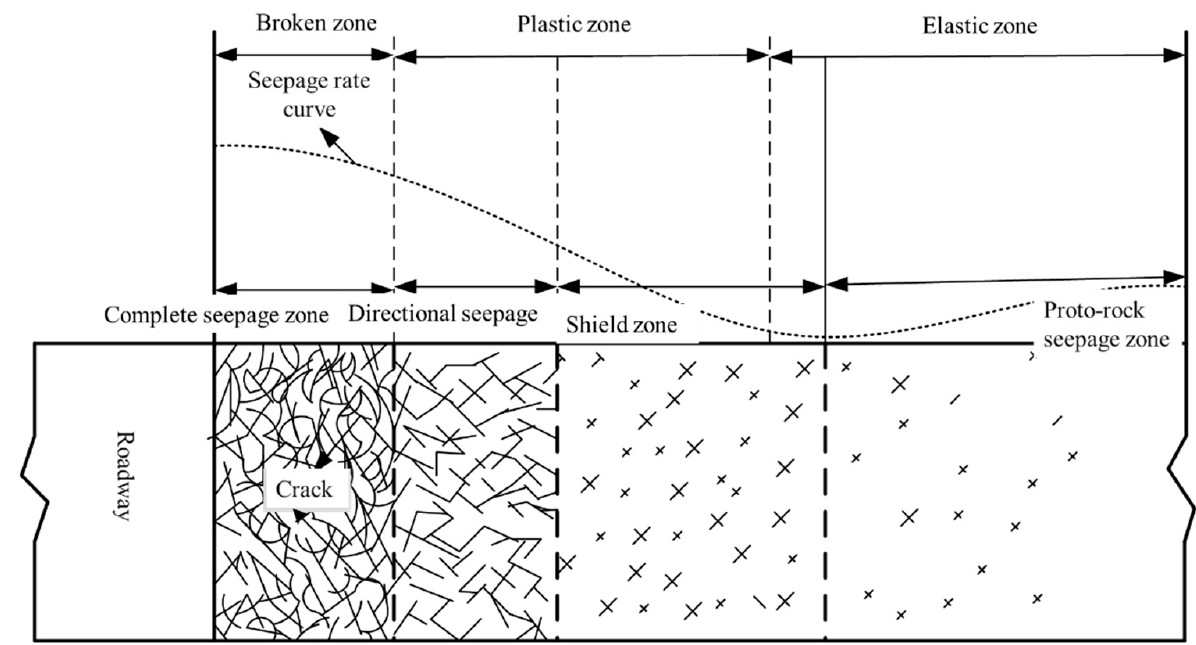
Figure 3. Radial seepage development characteristics of surrounding rocks.